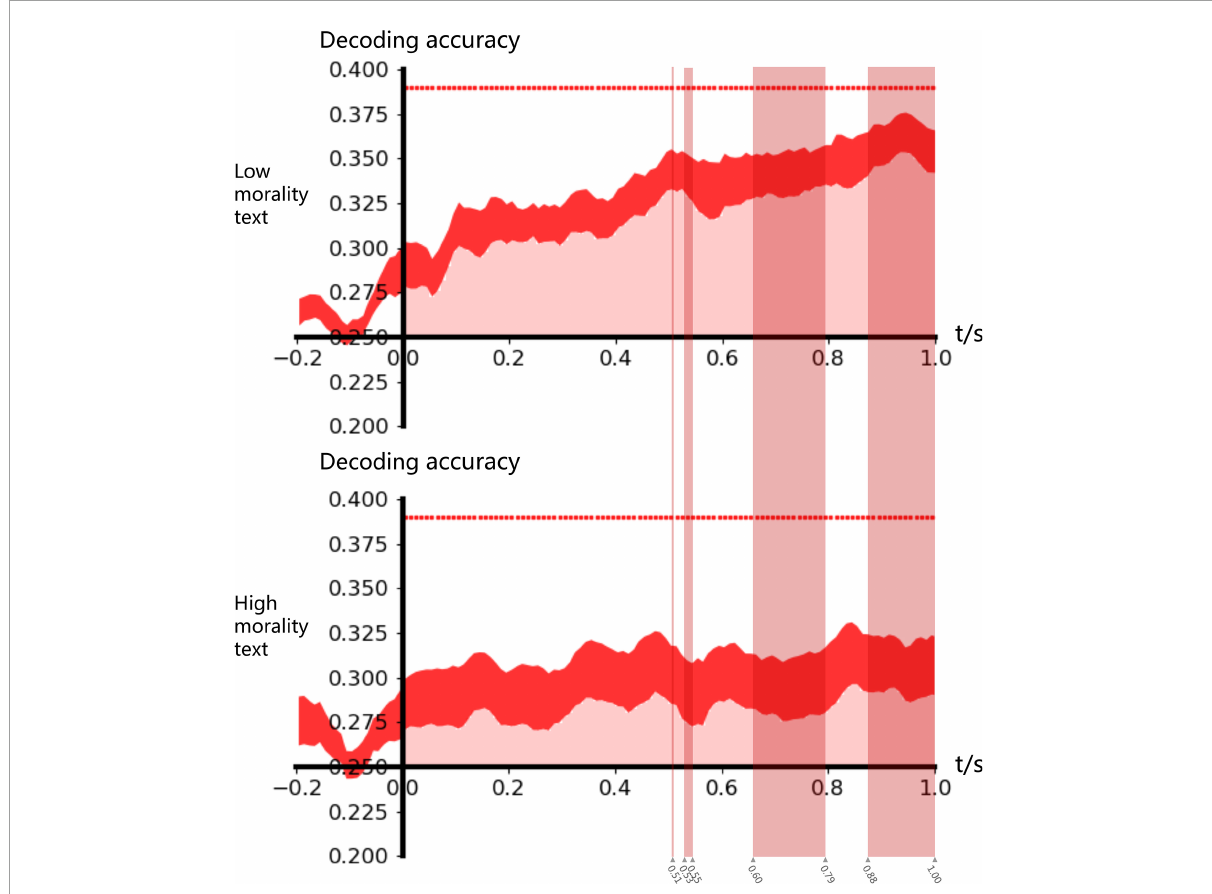
FIGURE4 ERP decoding accuracy. In 0–1 s, the classification accuracy was significantly greater than the random classification level of 0.25. In 0.51 s, 0.53–0.55 s, 0.66–0.79 s, and 0.88–1 s, the classification accuracy under the influence of high moral text was significantly greater than